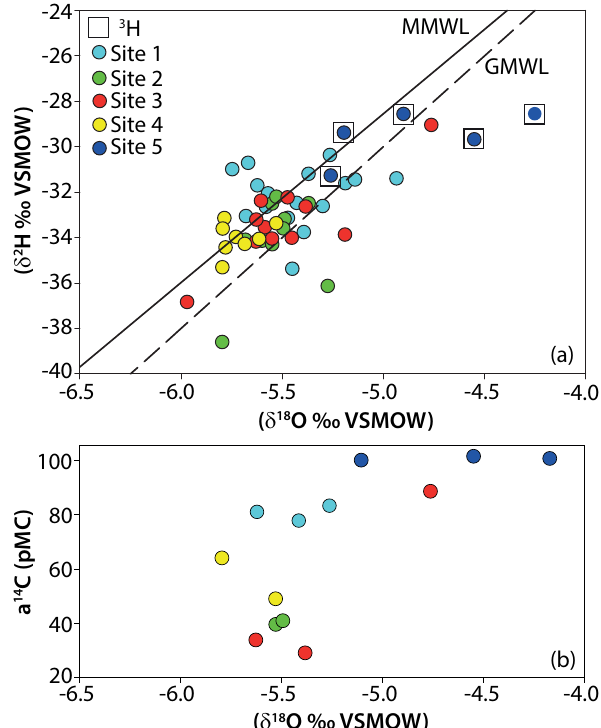
Figure 4. (a) 2 H vs. 18 O values of the Gellibrand River and sur- rounding groundwater sampled over March 2011–August 2013 and the weighted average for rainfall from Adelaide and Melbourne. MMWL = Melbourne Meteoric Water Line (Hughes and Crawford, 2012). GMWL = Global Meteoric Water Line (Clarke and Fritz, 1997). Groundwater with 3 H activities > 1TU is also highlighted. period included. (b) a 14 C vs. 18 O of groundwater